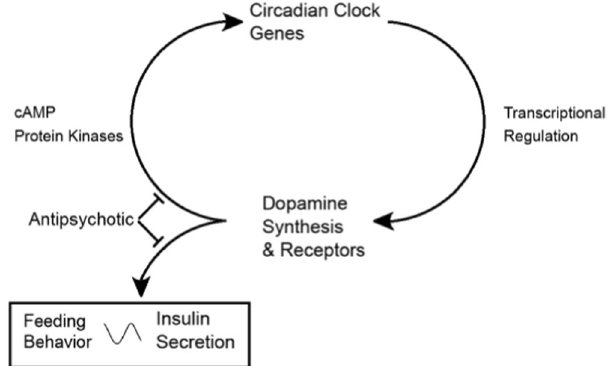
Fig. 3 Bidirectional connections link circadian clock genes to dopamine. Rhythmic control of dopamine synthesis and signaling in pancreatic beta cells may be one mechanism by which insulin rhythms are maintained. In blocking dopamine signaling, APDs may interfere with (1) rhythmic insulin secretion and (2) dopamine receptor feedback to the beta cell circadian clock. The timing of feeding behaviors may in fl uence rhythmic release of peripheral insulin